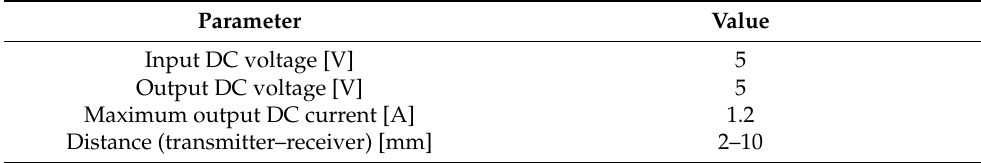
Table 4. Manufacturer ’ s declared parameters of WPT.